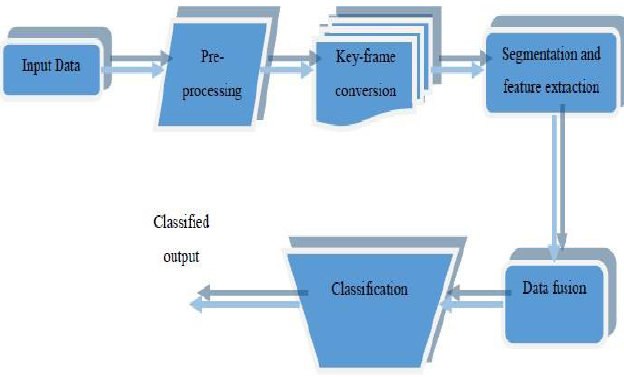
Figure 3. Block diagram of the proposed system